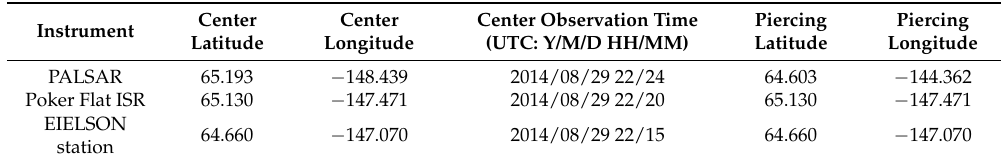
Table 2. Observing time and positions of three instruments. The off-nadir angle of PALSAR-2 in this table is 30.8